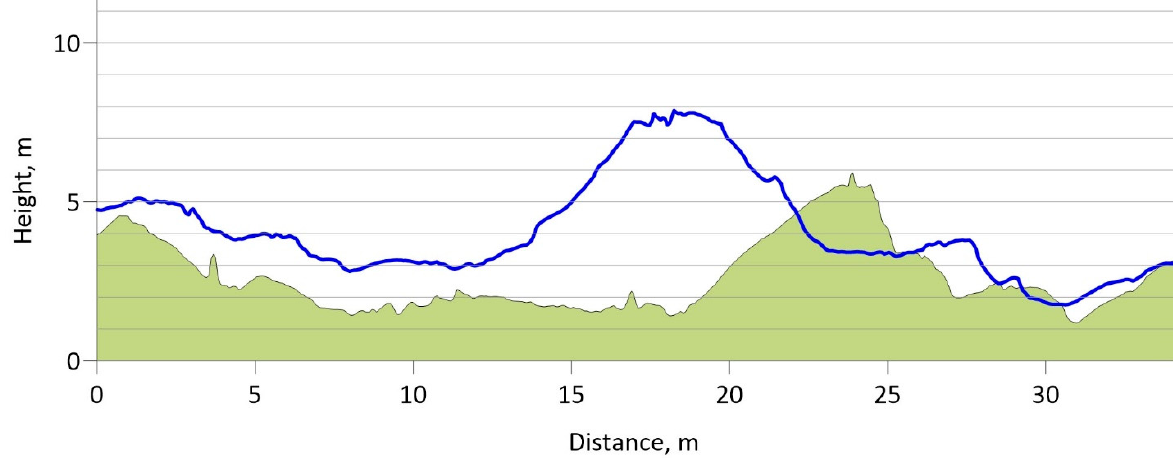
Figure 9. Site 1. Slope profile changes at site 1 in the period 2012–2019 (blue line) and 2014–2019 (green).